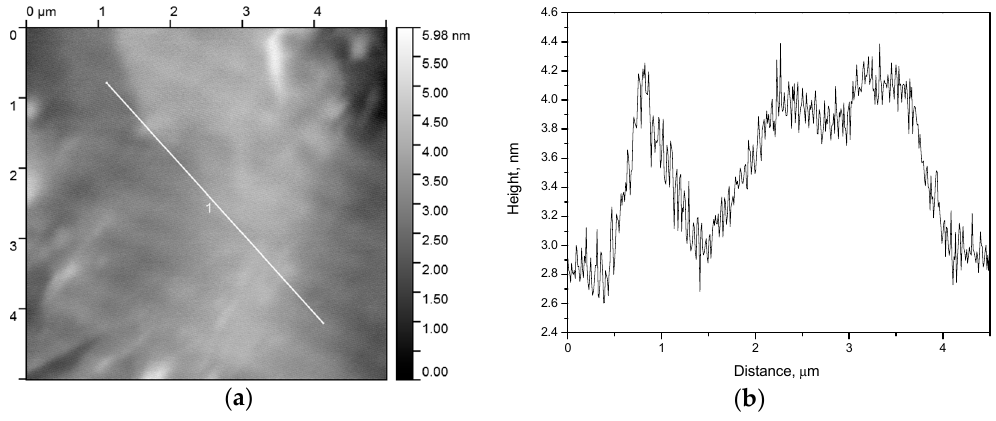
Figure 4. AFM image of the polished substrate with UFG titanium: a —front; b —slice by line 1 at previous picture.